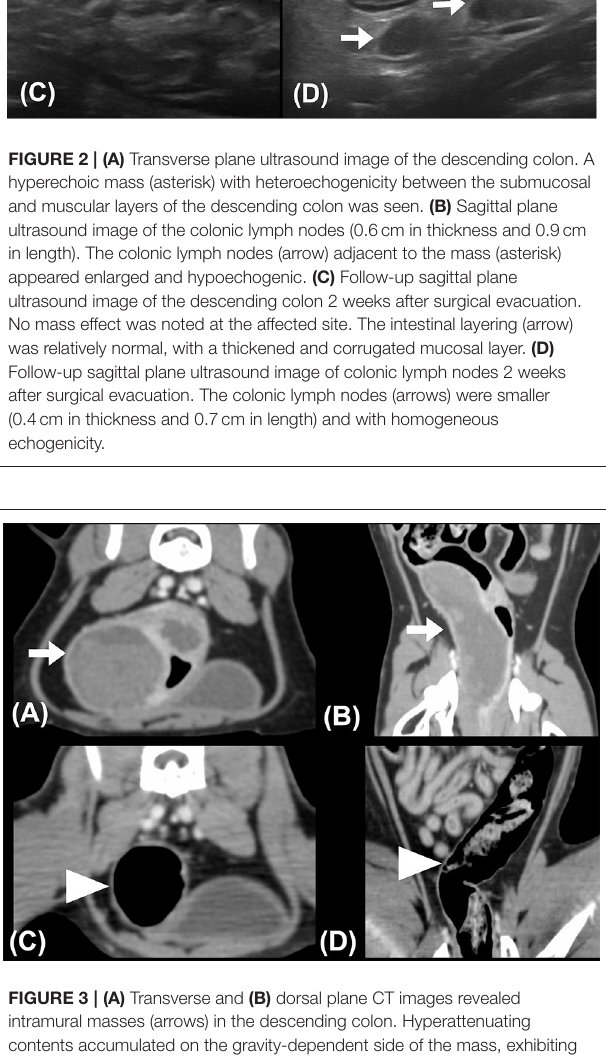
with a linear transducer (11 L-D, GE Healthcare; 4–10 MHz),